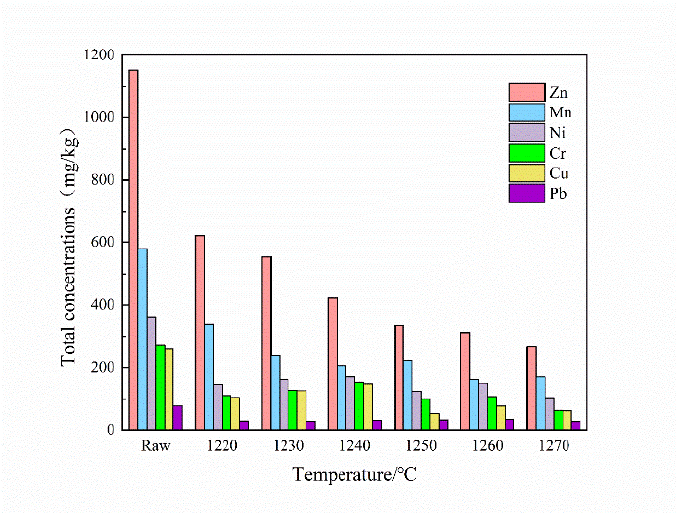
Figure 8. Total heavy metal concentrations at different sintering